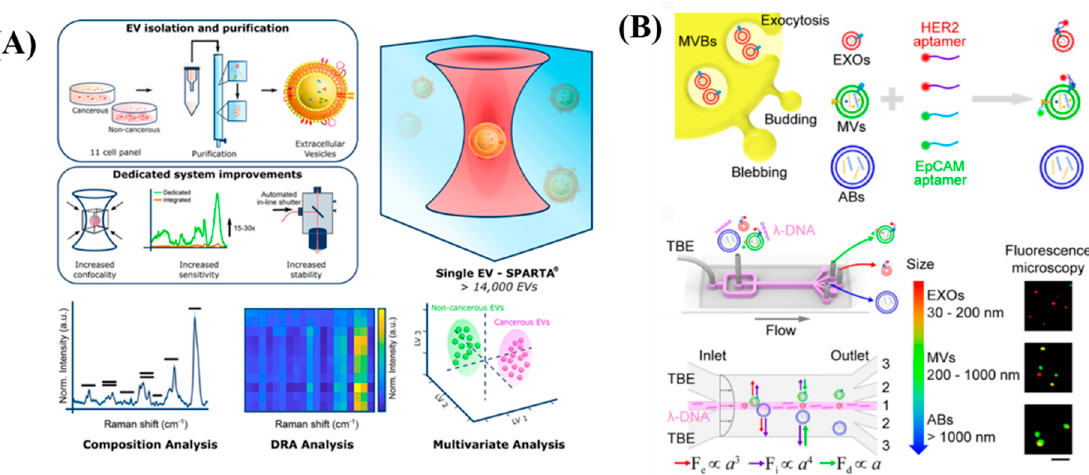
Figure 7. ( A ) Overall results of the SPARTA system. Re-used with permission from Ref. [74] and ( B ) Scheme of λ –DNA-mediated aptamer based analysis of individual EVs. Re–used with permission from Ref. [75]. (Copyright 2019 American Chemical Society).